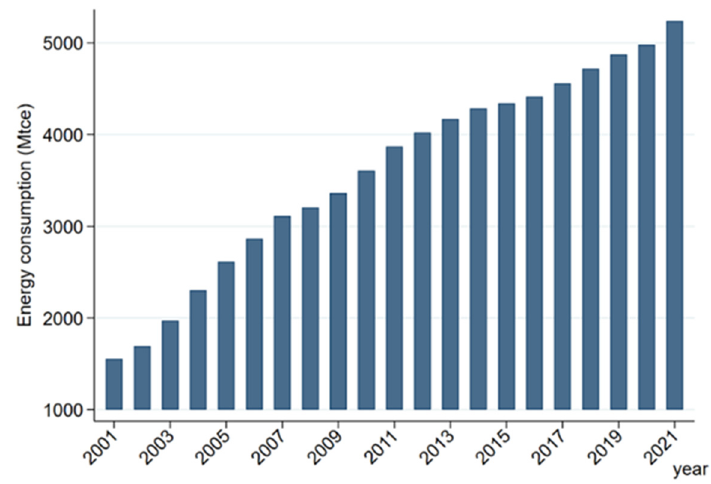
Figure 2. Energy consumption in China, 2001–2021.